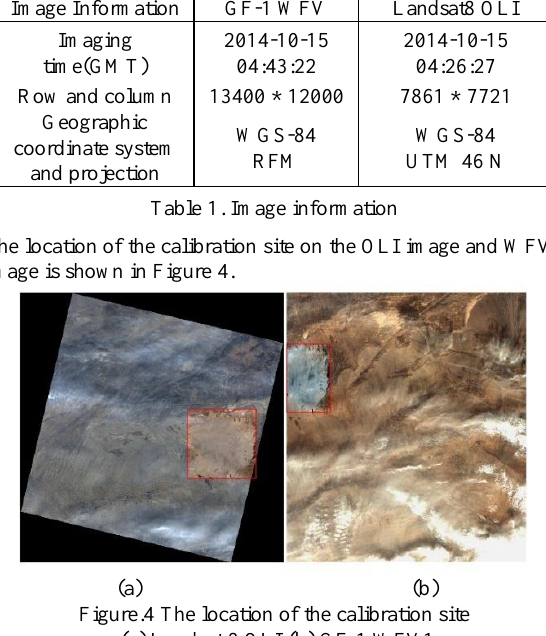
Figure.4 The location of the calibration site